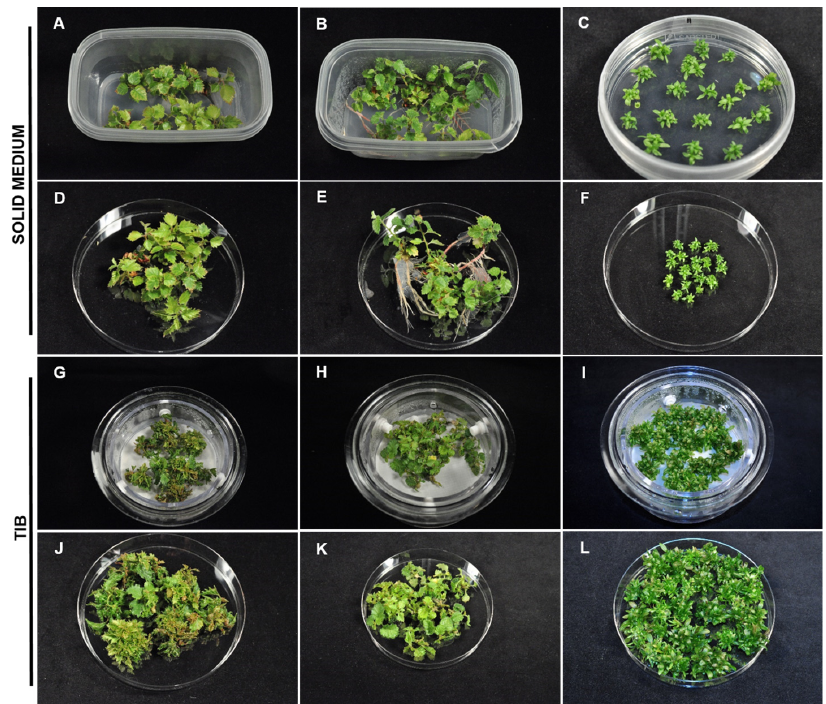
Figure 1. Plants and shoot cultures micropropagated on solid medium (top rows) and in the temporary immersion bioreactor (TIB) (bottom rows). ( A , D , G , J ) Plants of B. pendula after 6 weeks of culture on McCown’s Woody plant medium (WPM). ( B , E , H , K ) Plants of B. pubescens after 6 weeks of culture on WPM medium. ( C , F , I , L ) Shoot cultures of Eucalyptus after 2 weeks on Murashige and Skoog (MS) medium. ( D – F , J – L ) represent photographs of the plants and shoot cultures outside of the propagation vessels.